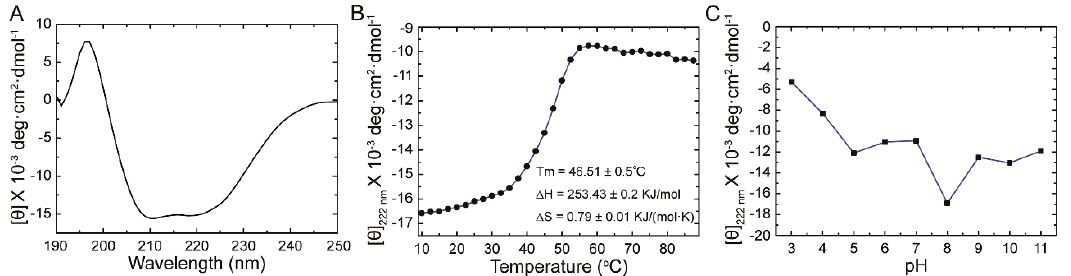
Figure 2. Secondary structure and stability analysis of BmADK. ( A ) CD spectra of BmADK. ( B ) Structural changes of BmADK induced by temperature. ( C ) Structural changes of BmADK in pH range of 3.0–11.0. The mean residue ellipticities at 222 nm are used to represent the structural changes of BmADK induced by pH and temperature.